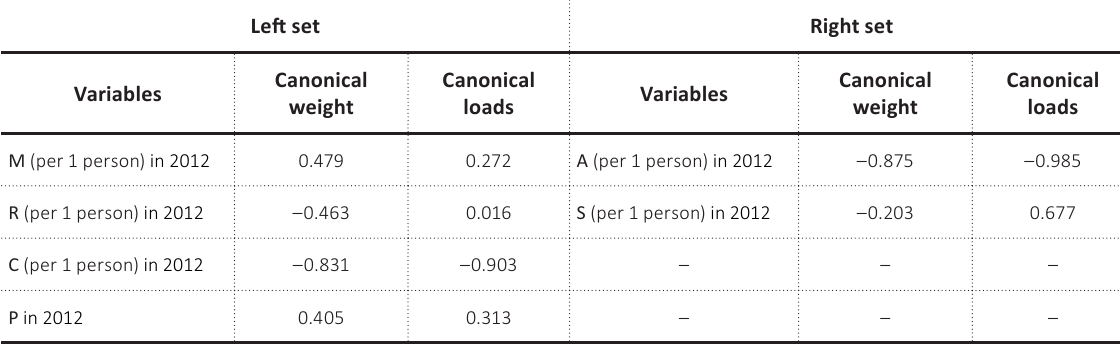
Table 4. Canonical weights and loads of variables of the first canonical root Left set Right